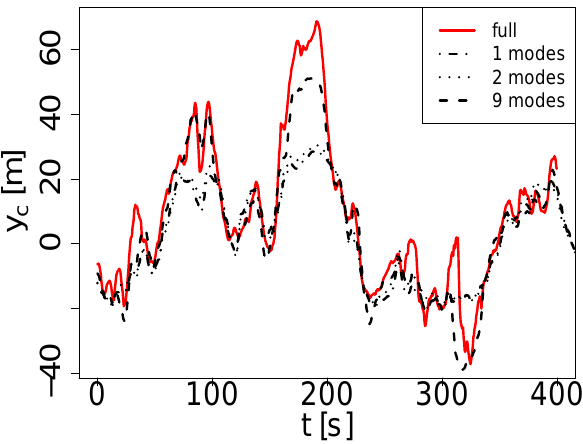
Figure 14. The horizontal position of the deficit y using different numbers of